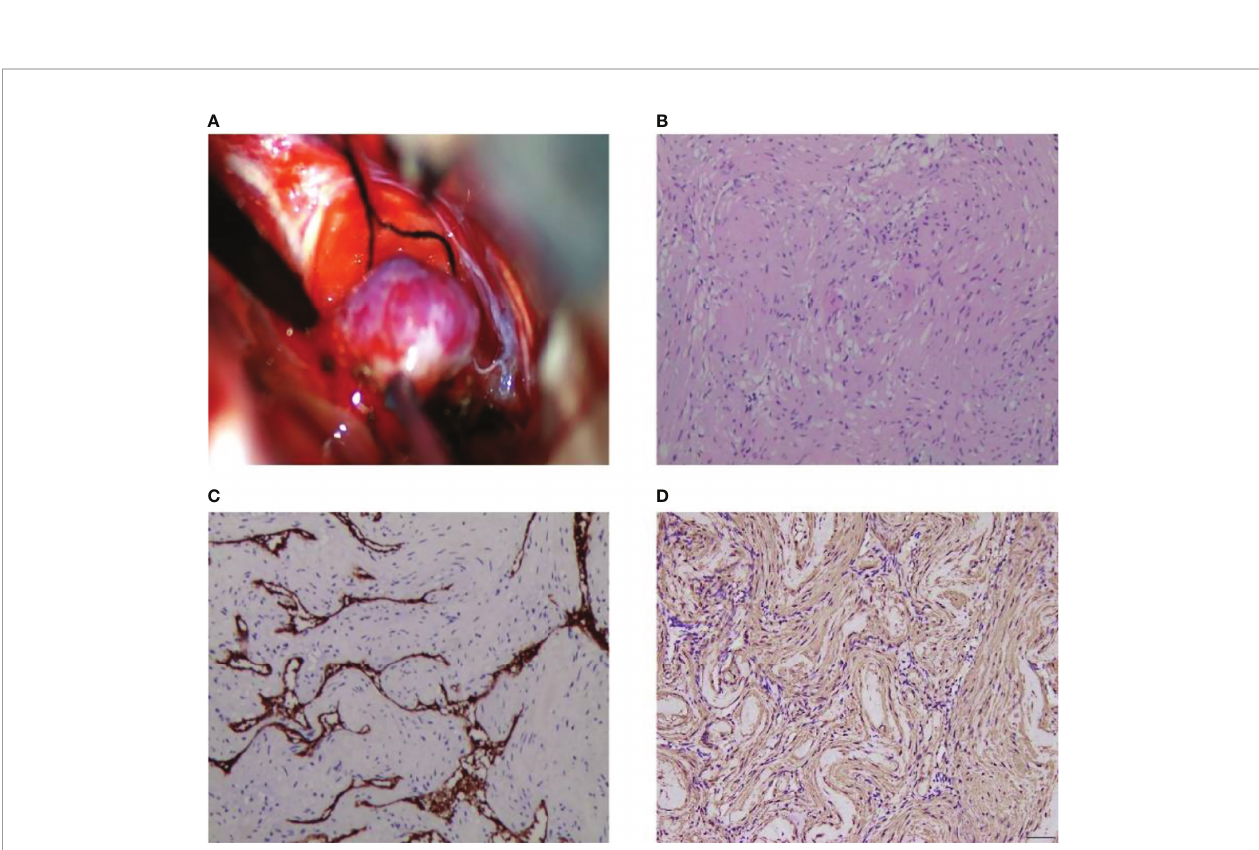
FIGURE 3 | Intraoperative MPC appears as a pink soft-tissue mass (A) . Histological and immunohistochemical features of MPC. Hematoxylin-eosin staining showed that the tumor was composed of abundant spindle cells, which grew in concentric circles around small blood vessels (B) . Immunohistochemical staining presented CD34 (+) (C) , SMA (+) (D) . [Original magni fi cations: (B – D)